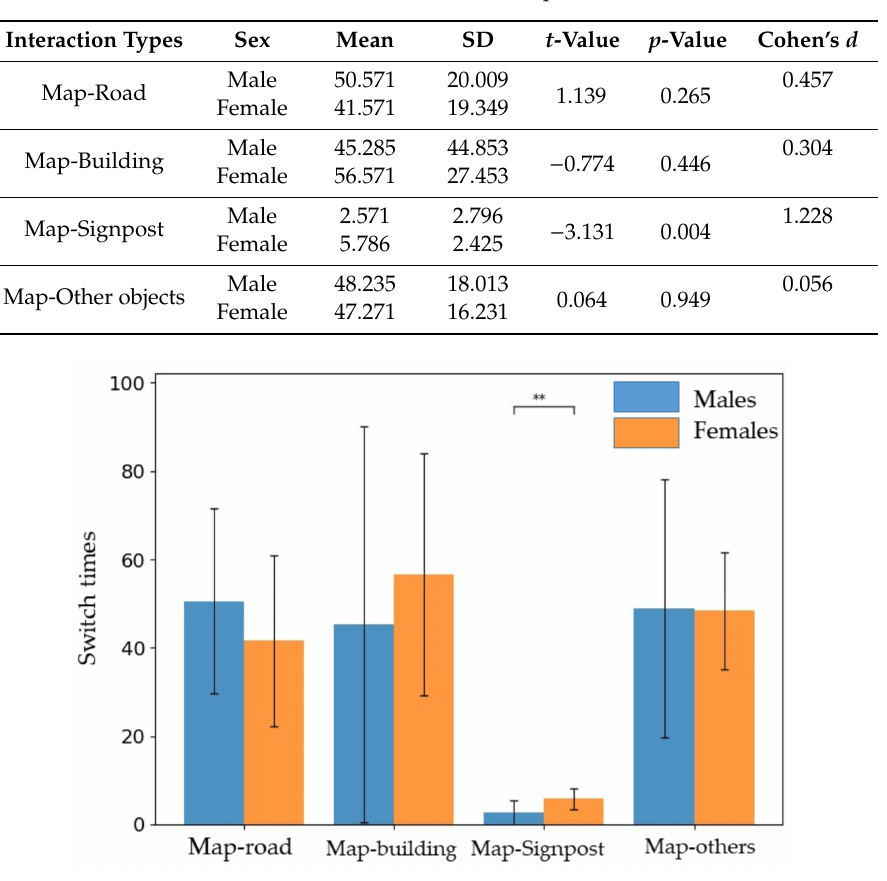
Figure 7. The interaction between the map and other AOIs (** p < 0.01; Error bars denote the 5and 95th percentile values of a